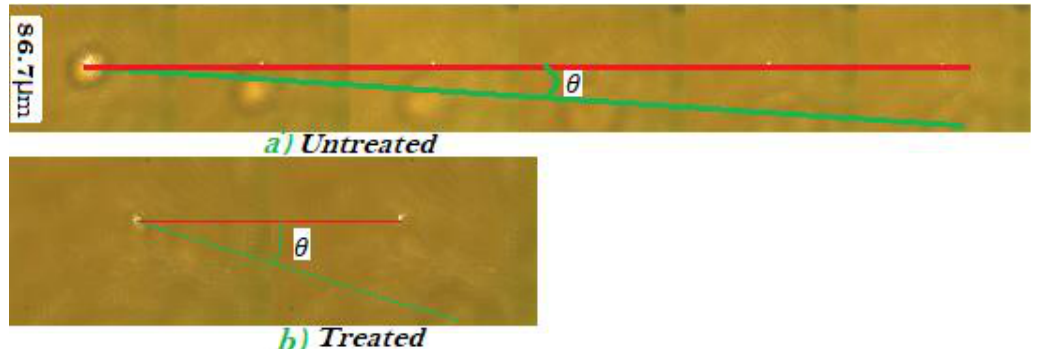
Figure 3. Motion of the ( a ) untreated and ( b )treated ejected cells. The faster-ejected cells have a small number of consecutive frames with larger 𝜃, and the slower-ejected ones have a larger number of consecutive frames with small 𝜃 .